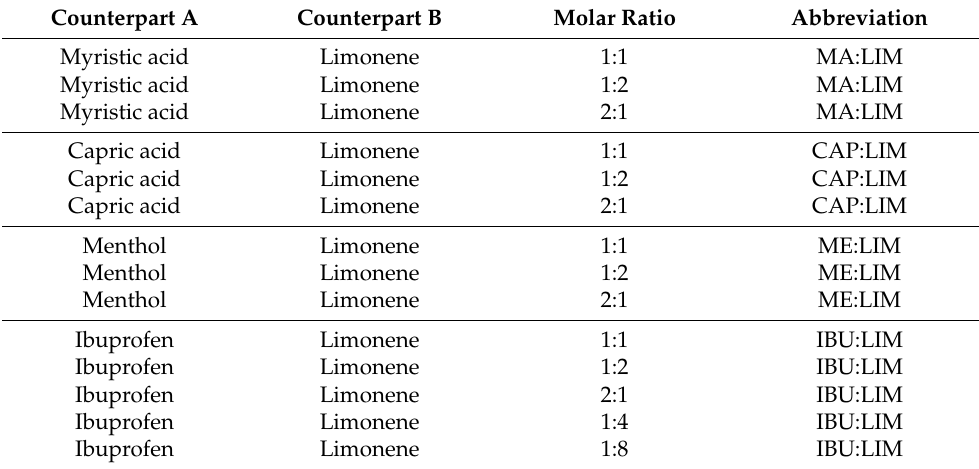
Table 4. Limonene-based therapeutic deep eutectic